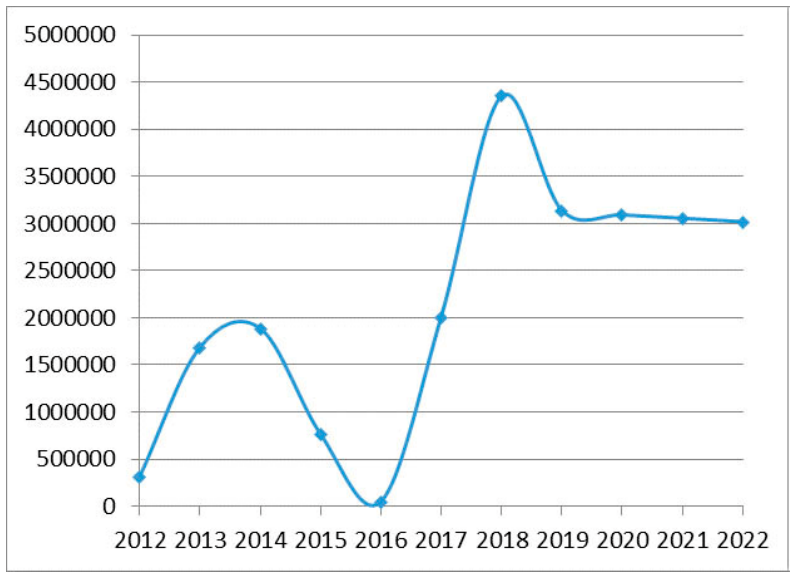
Figure 1. Modeled strategic values of commission income for Post Bank, in thousand rubles (devel- oped by authors V.V. Manuylenko, A.I. Borlakova).